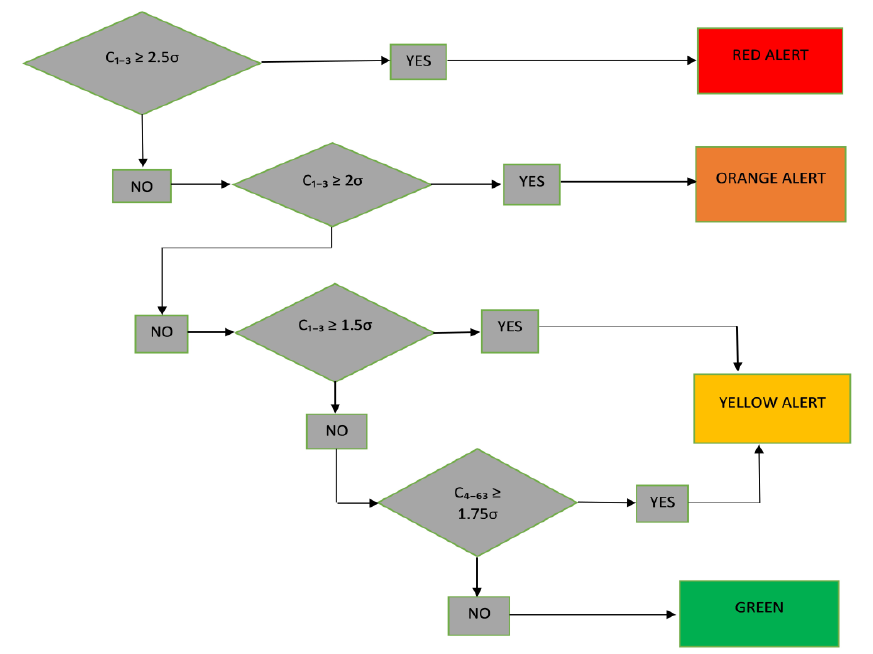
Figure 5. Algorithm used for calibration of the SIGMA model for Kalimpong town.